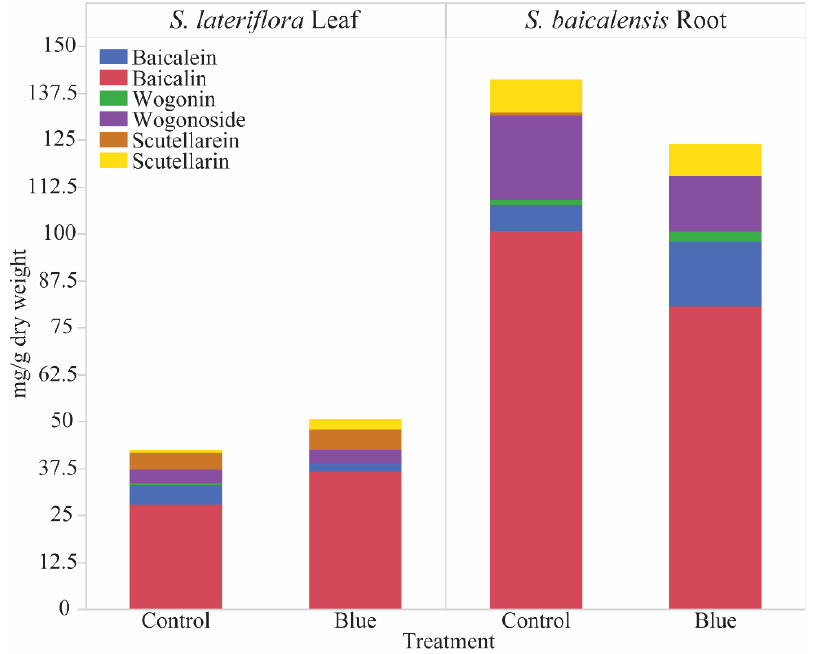
Figure 4. Blue light quality impacts flavone accumulation in primary localization tissues of Scutellaria species. Data presented as means of flavone concentrations ( S. lateriflora n = 12, S. baicalensis n = 11). Table 1. Quantification of 4’-deoxy and 4’-hydroxy flavones under blue light treatment.